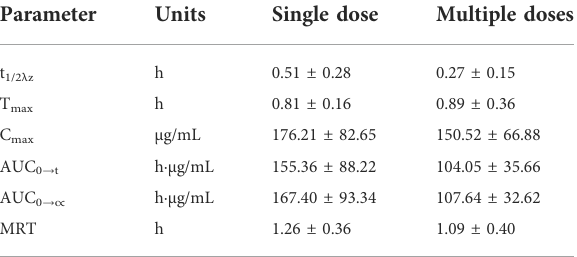
TABLE 5 Comparison of the mean pharmacokinetic parameters of exogenousGlnbetweensingleandmultipleoraladministrationof 240 mg/kg Gln tablets in Beagls (mean ± SD, n = 6).